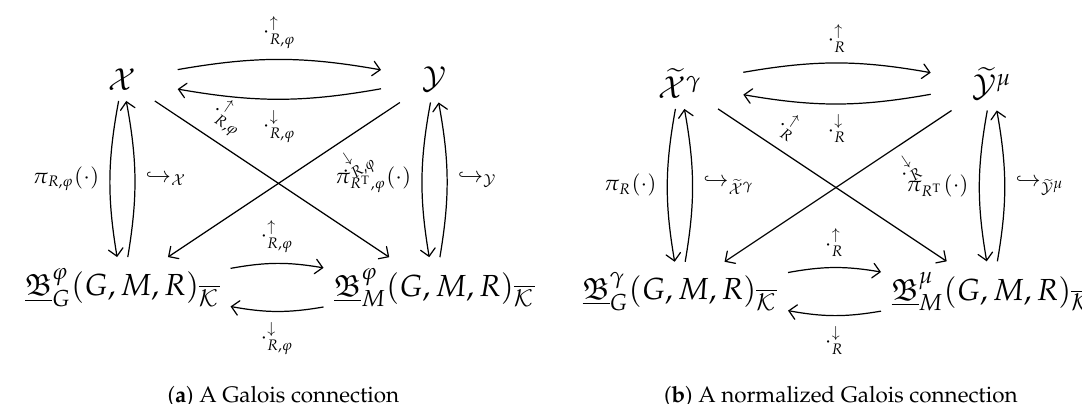
) : X (cid:40)(cid:42) Y , · ↓ R , ϕ R , ϕ